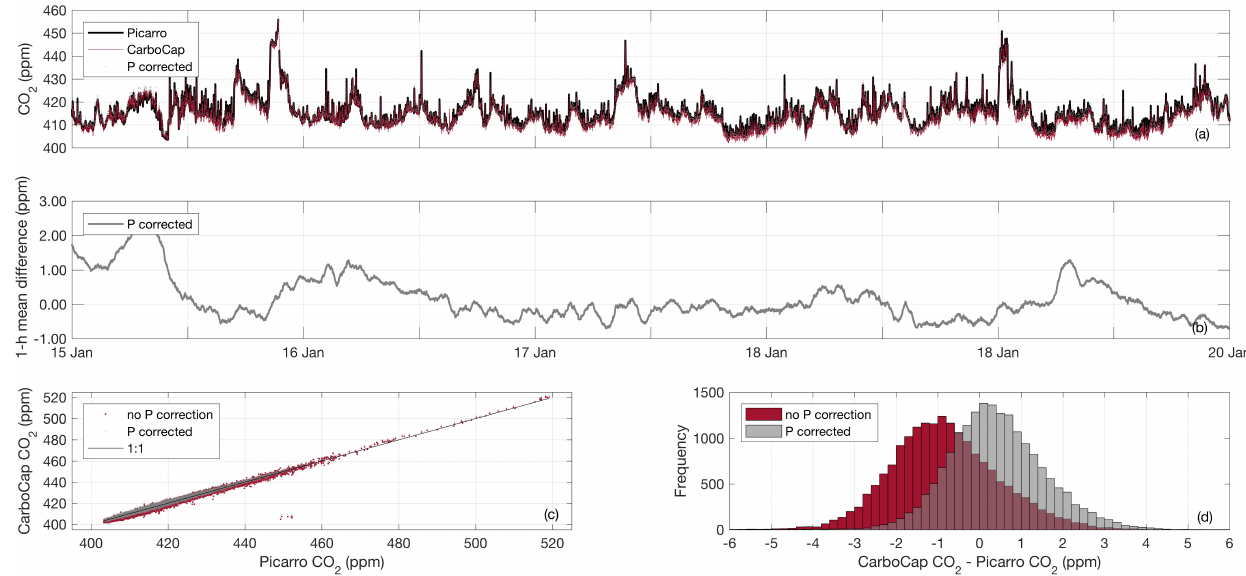
Figure 5. 1 min mean results from a two week co-location of a Vaisala CarboCap GMP343 and a custom cavity ring-down reference instrument based on the Picarro G2301 system: (a) representative five day time series, (b) 1h running mean of the differences over the same five day period, (c) direct comparison, (d) histogram of the differences. CarboCap observations are dry air mole fractions calculated using Eq. (1) and subsequently pressure corrected with Eq.